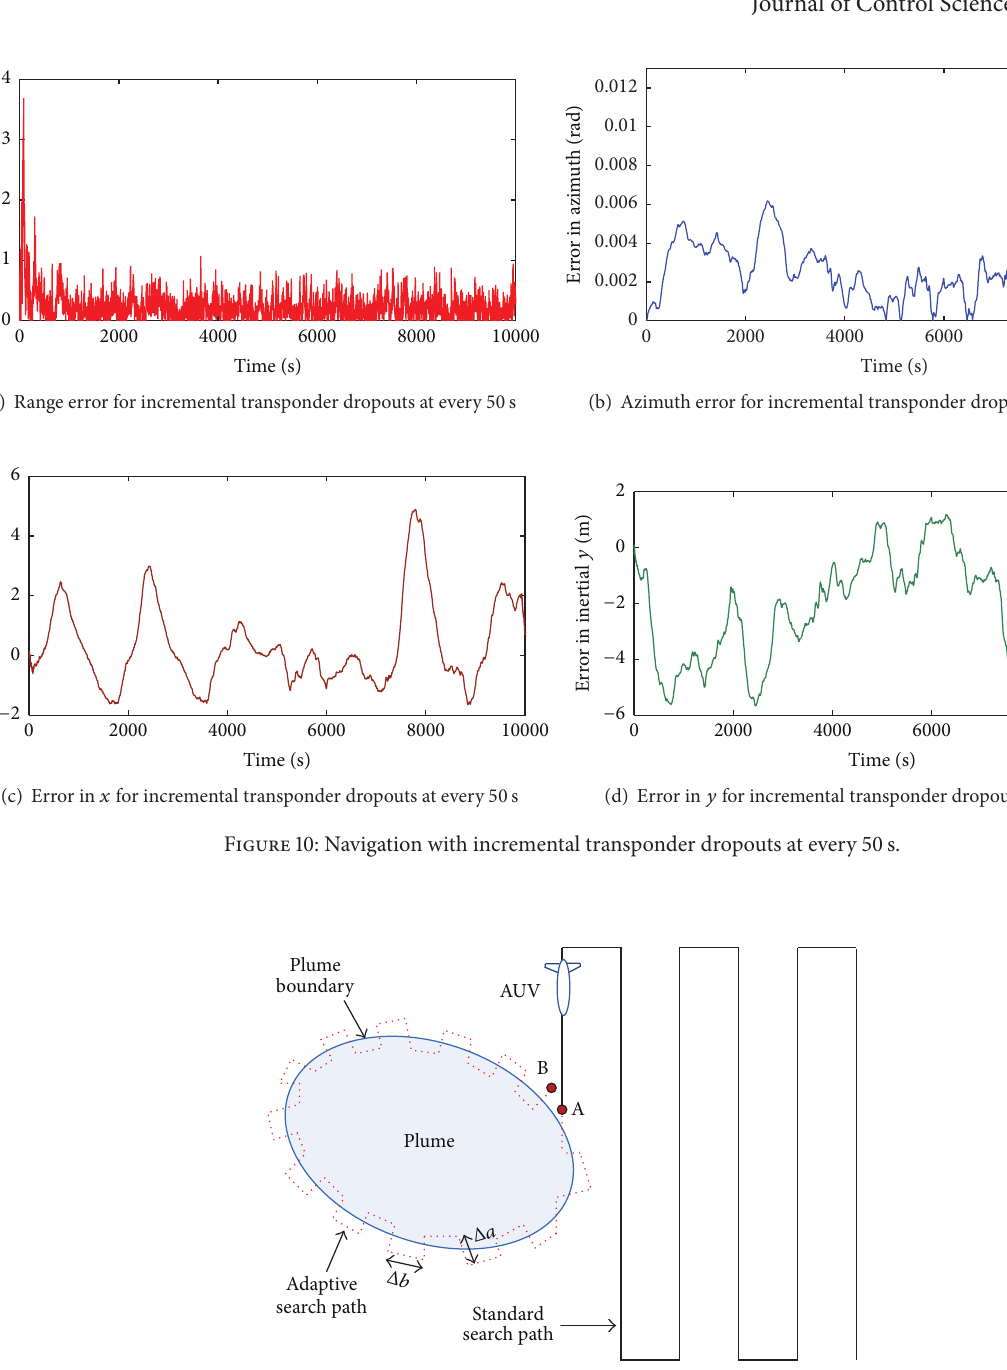
Figure 11: Plume boundary